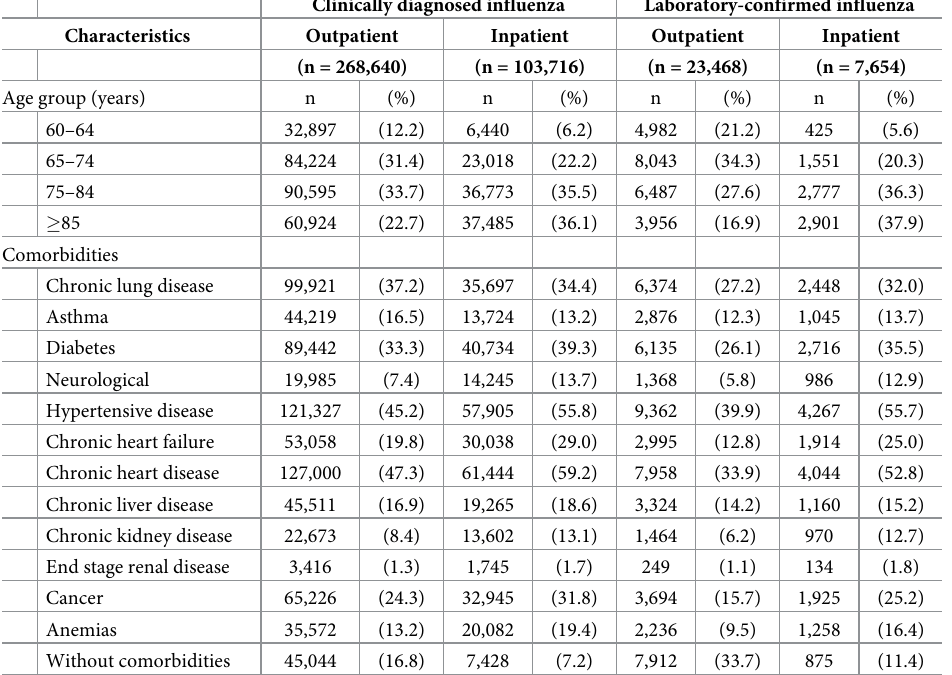
Table 3. Characteristics of medically-attended patients with clinically diagnosed and laboratory-confirmed influ- enza by care setting, from 2010/2011 to 2018/2019. Clinically diagnosed